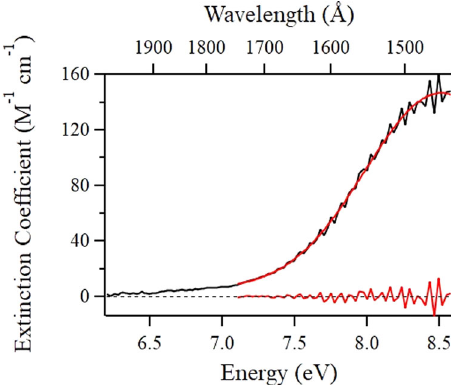
Fig. 4 Supercritical CO 2 spectrum at 19 bar and fi t. Experimental data at 0.036 g cm − 3 are shown (black curve) along with Gaussian fi t (red curve). The resulting residual can be seen at the bottom of the graph. The dashed black line is placed merely to guide the eye through a vertical intercept of 0.